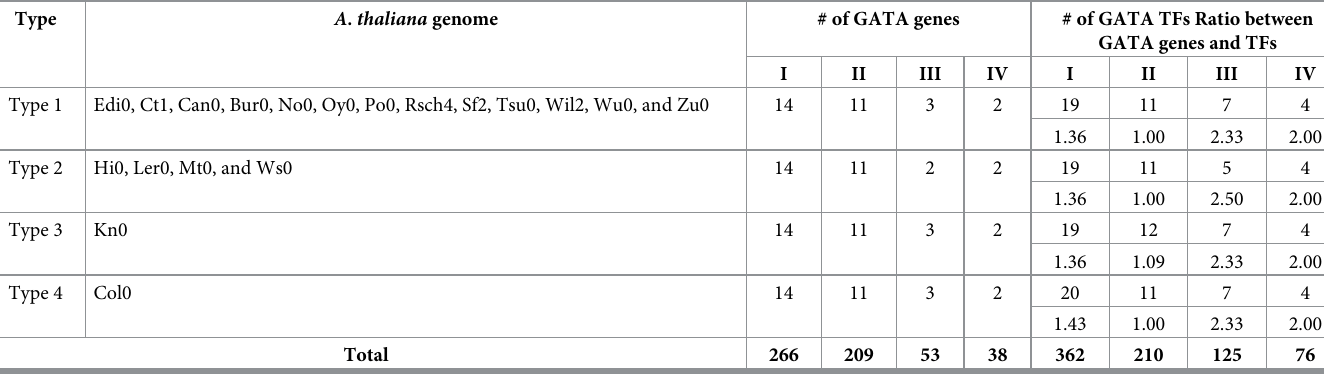
edulis [87] have been identified, presenting that only three or four subfamilies identified from dicots were mentioned (Table 3). Two GATA genes (PeGATA6 and PeGATA11) from P . edulis and two GATA genes (TaGATA-A2 and TaGATA-A11) from T . aestivum contain two or three GATA domains [79,87],which should be classified into subfamily VI based on the study of Oryza sativa [73], indicating that new criteria for classifying subfamilies of GATA genes should be established again against available hundreds of plant genomes. There are four types of distribution of GATA TFs along with four subfamilies identified in 19 A . thaliana genomes (Table 4). The largest one (Type 1), which is from thirteen out of 19 A . Table 4. Number of GATA genes identified from 19 A . thaliana genomes along with subfamilies.